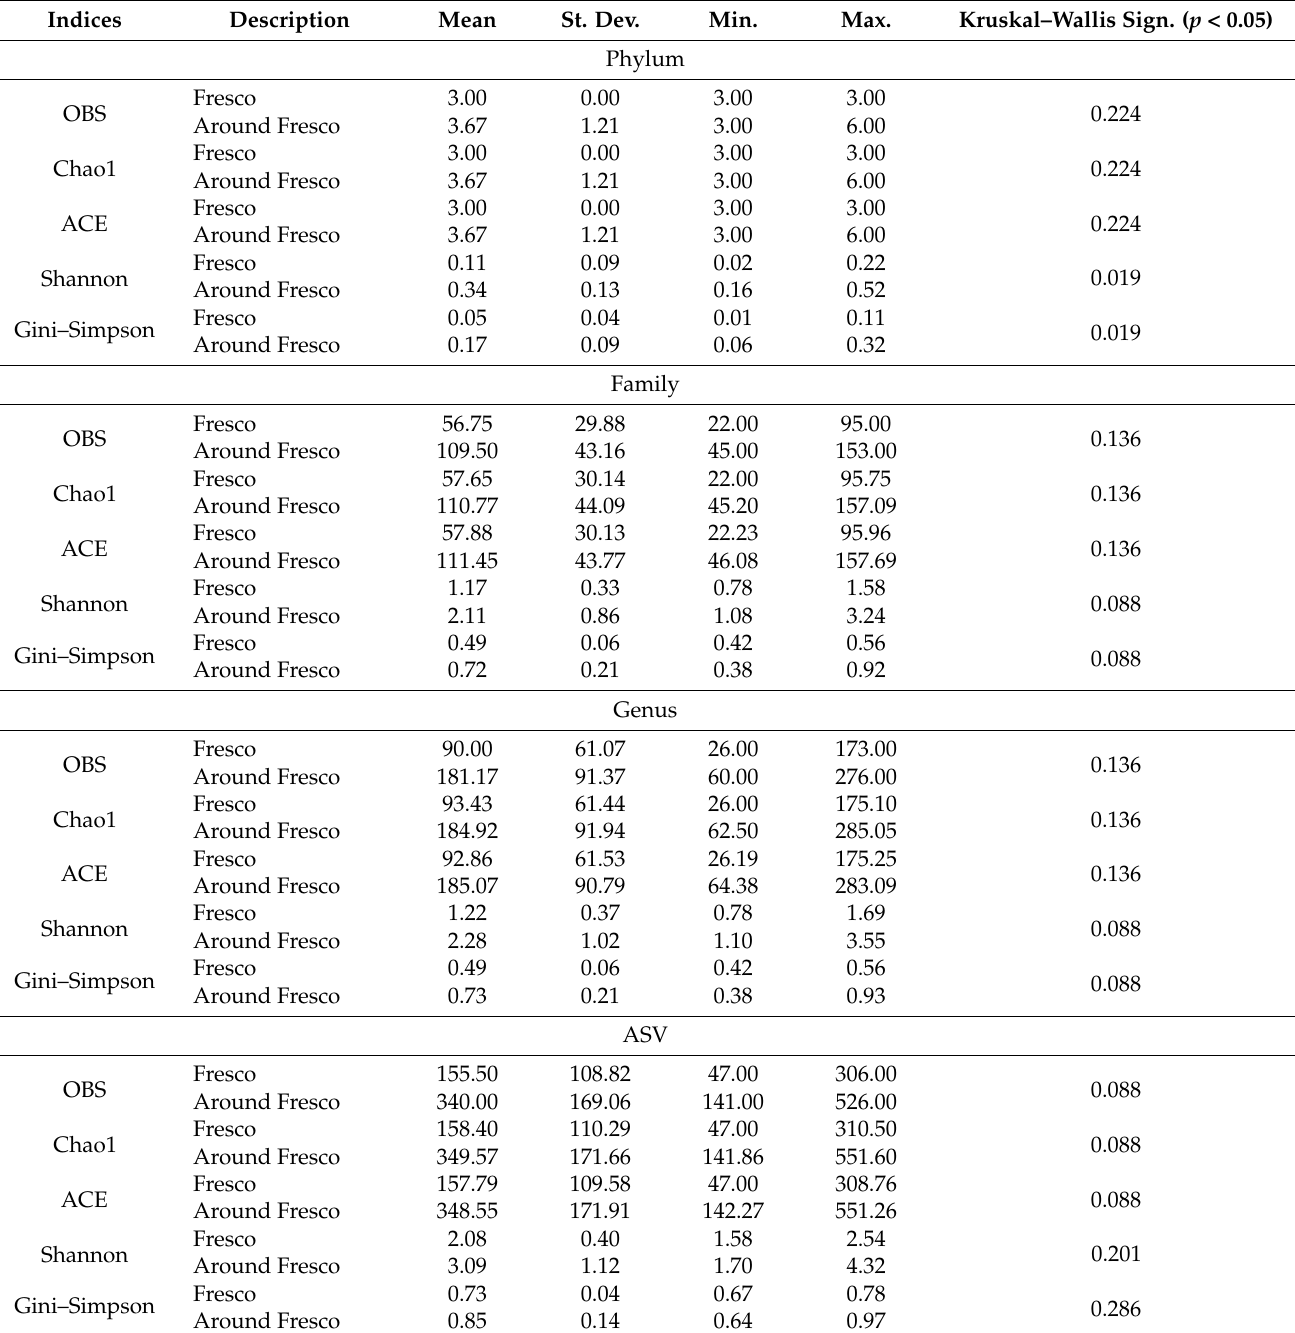
showed, among all samples from the wall deposit, the lowest richness and diversity. Table 3. Alpha diversity within the analyzed samples from fresco and around it (average values) and presented at the phylum, family, genus, and ASV taxa